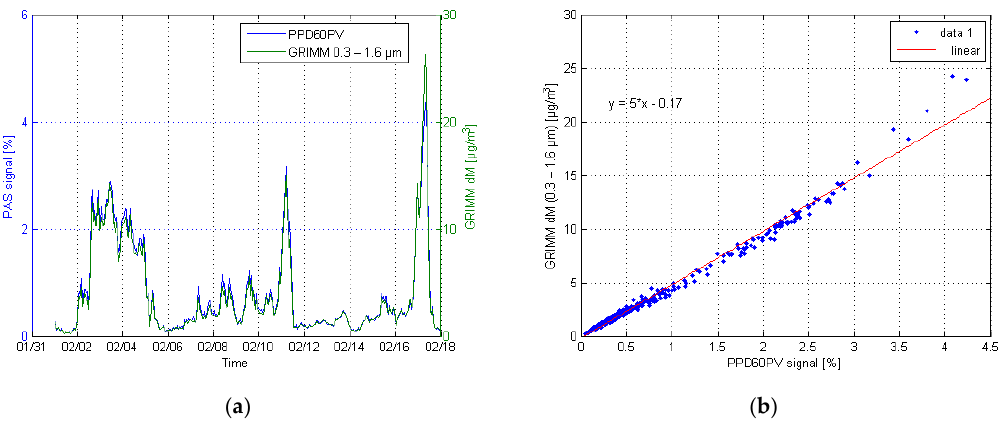
Figure 11. Time series ( a ) and correlation plot ( b ) of the PPD60PV and GRIMM channels 2–7.